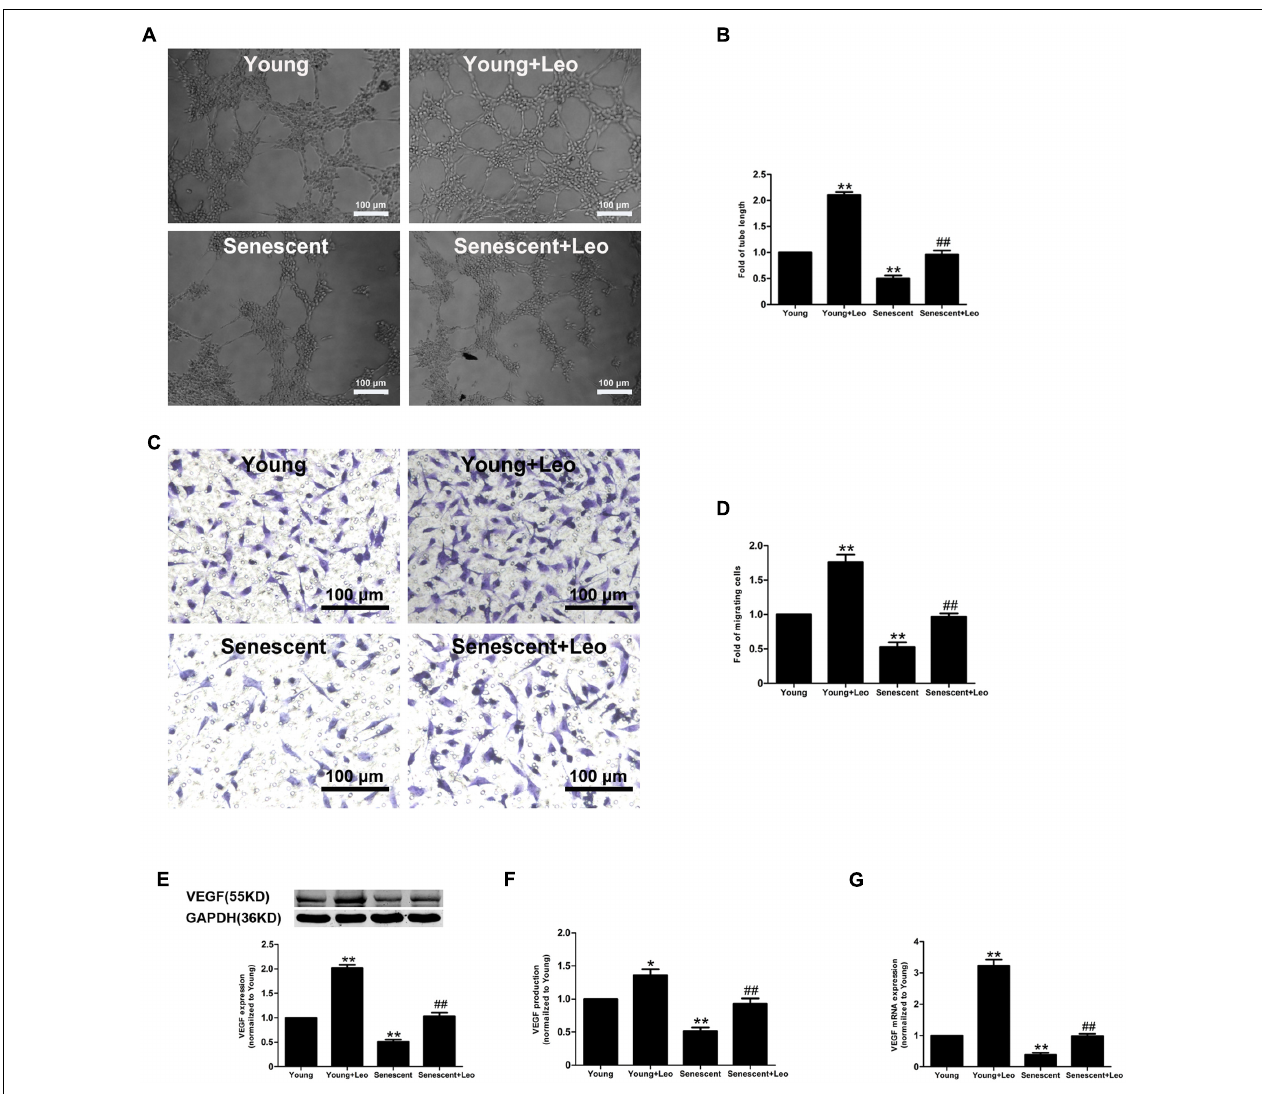
FIGURE 7 | Effects of leonurine on the endothelial functions in senescent HUVECs. (A,B) Representative micrographs and quantification of tube formation in HUVECs treated as indicated ( n = 3 each). Scale bar = 100 µ m. (C,D) Representative images and quantitative analysis of cell migration with migration assay in HUVECs treated as in (A) ( n = 3 each). Scale bar = 100 µ m. (E–G) Effects of aging and leonurine on VEGF expression, secretion and mRNA expression in HUVECs. ∗ p < 0.05 vs. young group; ∗∗ p < 0.01 vs. young group; ## p < 0.01 vs. senescent group. Data are mean ±